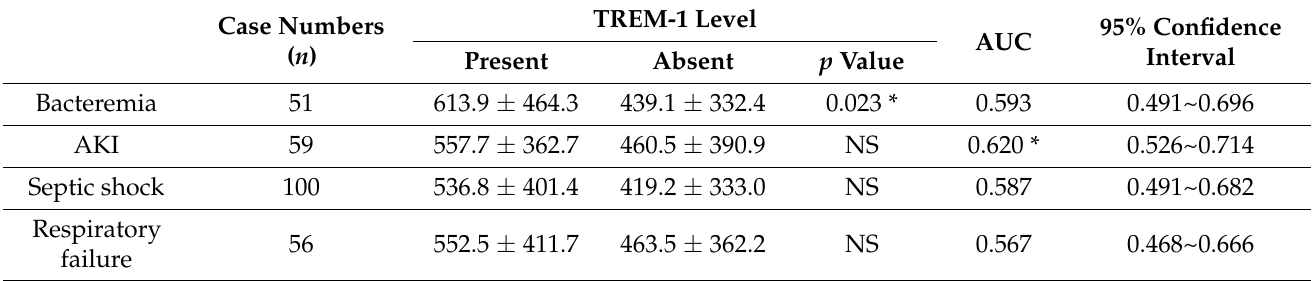
Table 5. sTREM-1 in predicting different organ